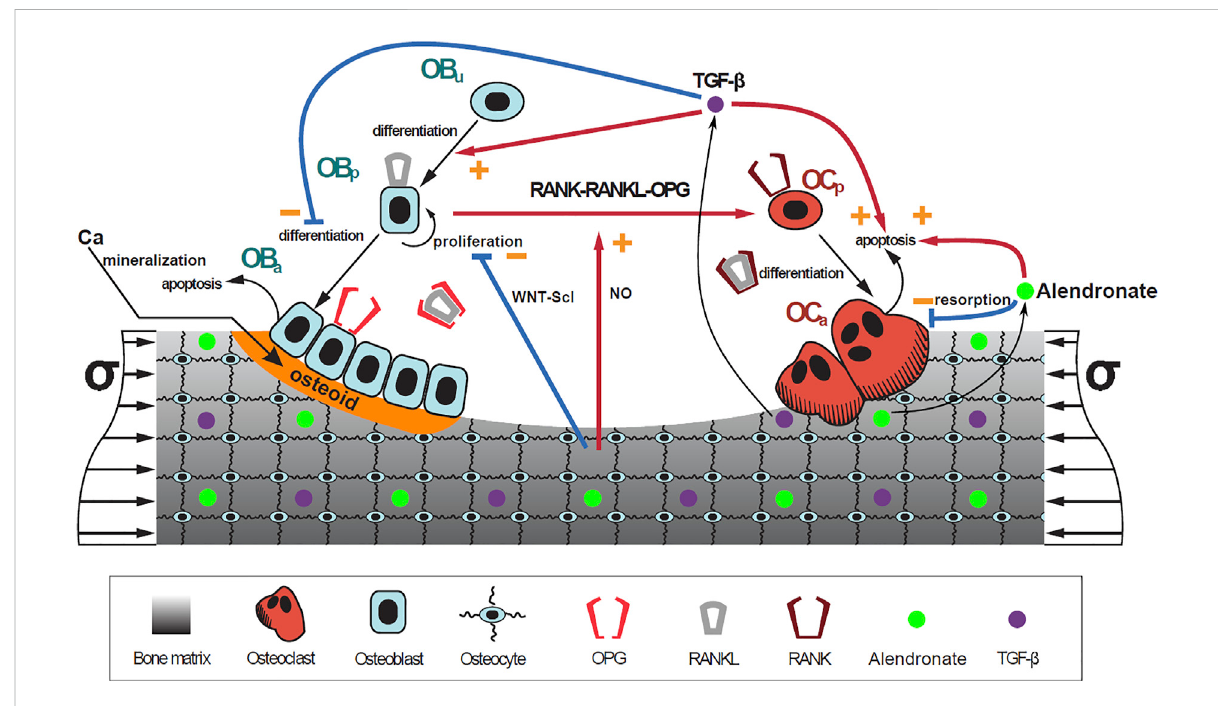
FIGURE 3 Schematic representation of the mechanistic PK-PD model: bone cell differentiation stages along with biochemical and biomechanical interactions are presented. The mineralization of osteoid is shown in orange. Alendronate doses lead to the distribution of the drug into the bone compartment where it interacts with the